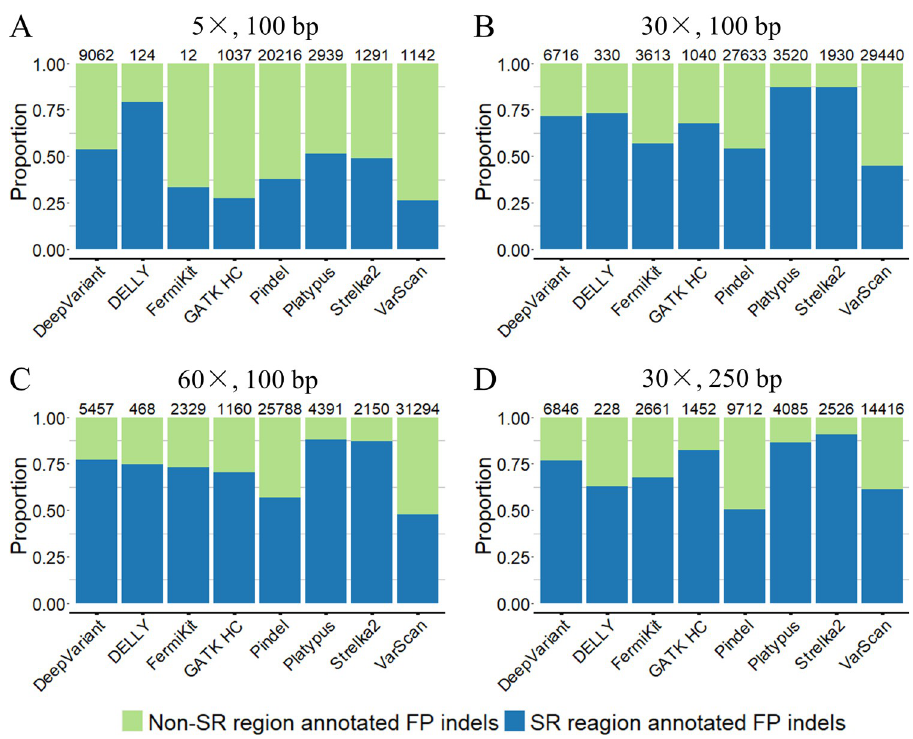
Fig 6. The proportions of SR regions annotated FP indels of the tools with the semi-simulated dataset. (A) 5 × coverage, 100bp read length sequencing data. (B) 30 × coverage, 100bp read length sequencing data. (C) 60 × coverage, 100bp read length sequencing data. (D) 30 × coverage, 250bp read length sequencing data. The numbers on the top of each bar are the total numbers of FP results called by each tool with corresponding sequencing